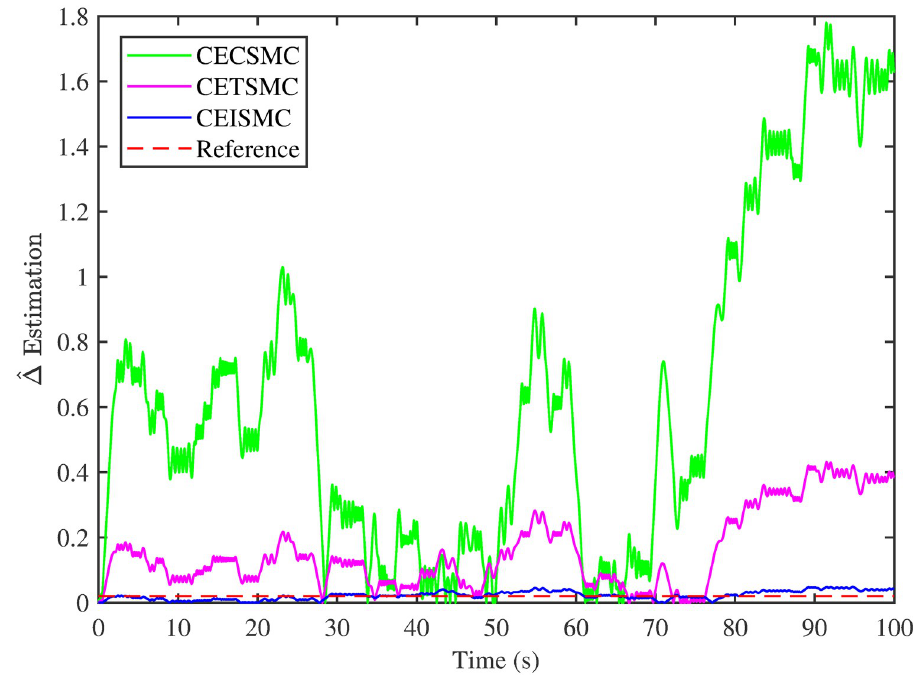
Fig 10. Delta estimation versus